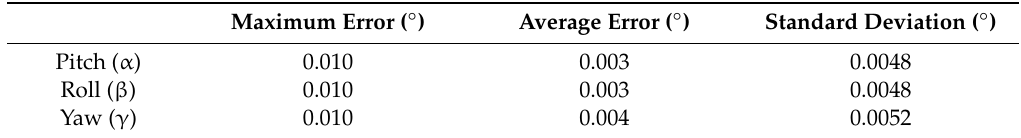
Table 8. Evaluation of Orientation measurement.